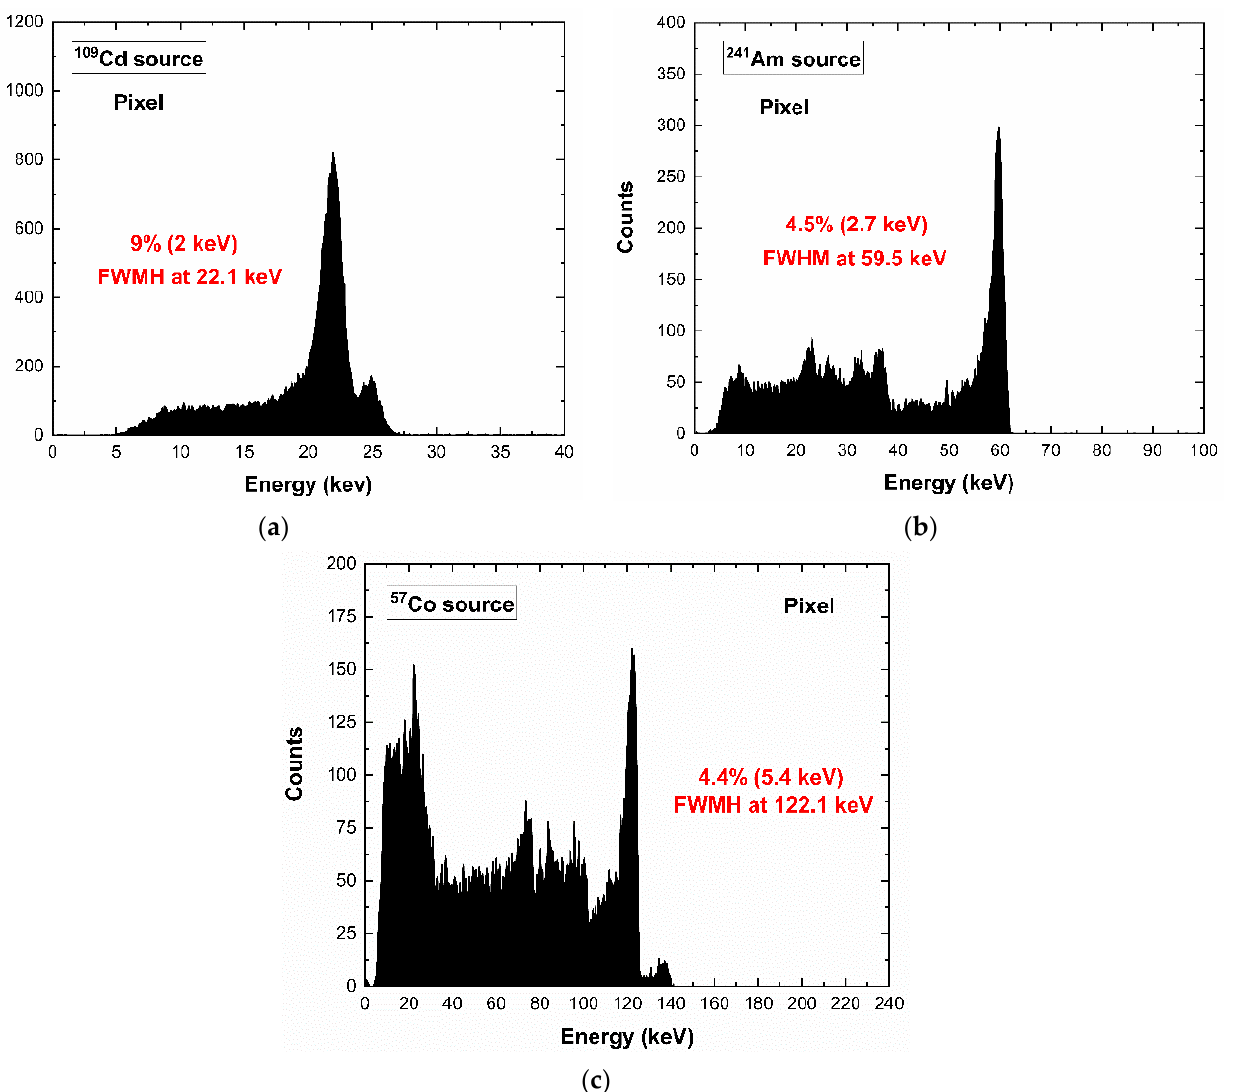
Figure 5. ( a ) 109 Cd, ( b ) 241 Am, ( c ) 57 Co energy spectra of a tested pixel at room temperature; the low-energy background and the peaks at 23.2 and 27.5 keV are due to the charge sharing effects and fluorescence crosstalk.